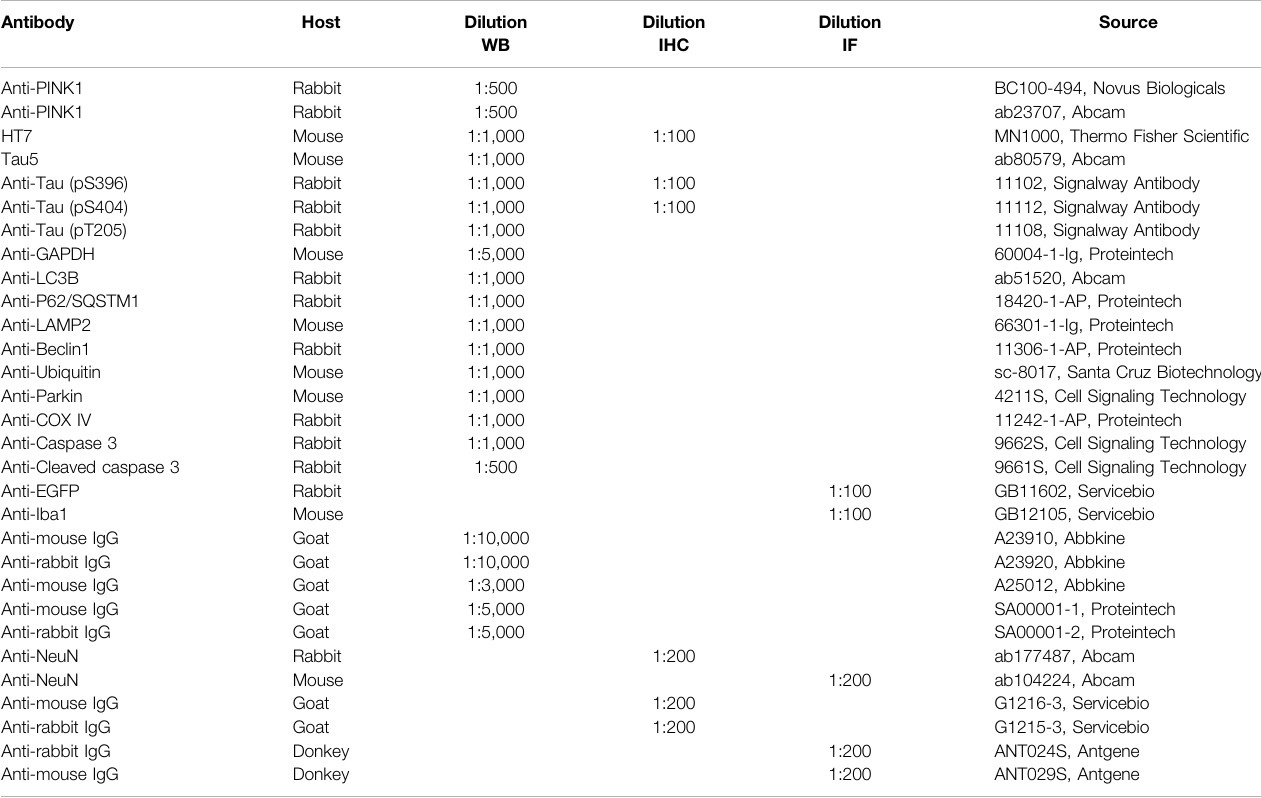
TABLE 1 | Antibodies used in this